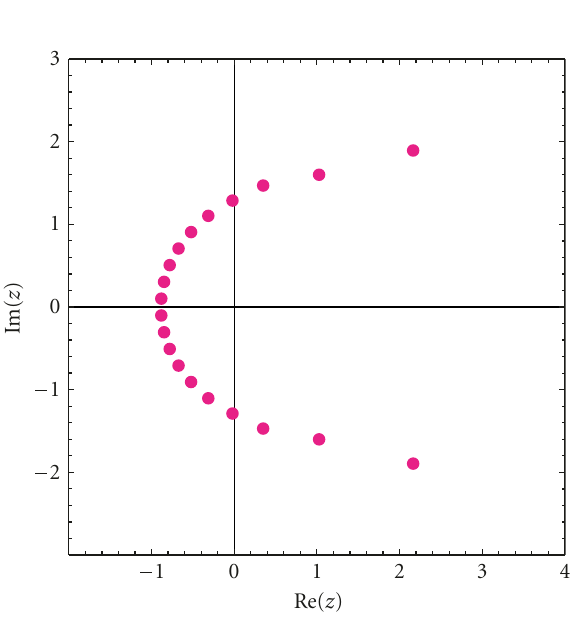
Figure 4.6 . Zeros of E 20, q , w ( x